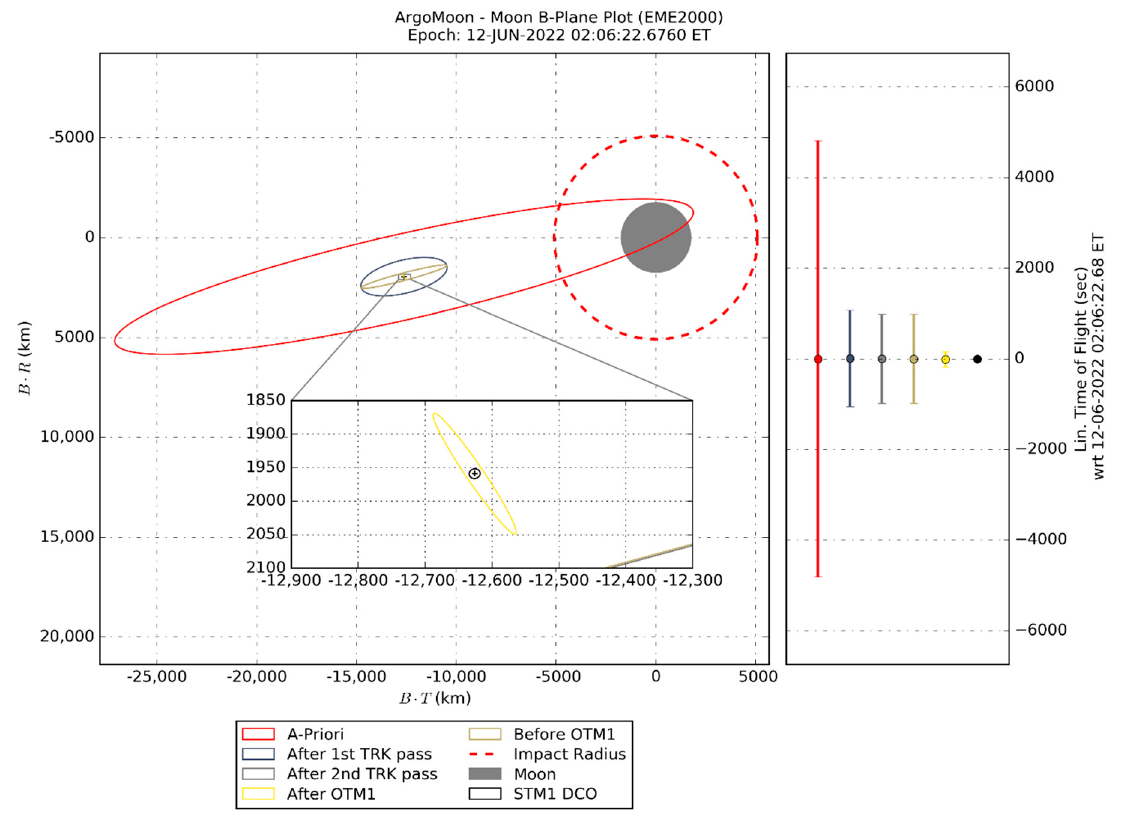
Figure 12. B-Plane uncertainties (3-sigma) for the fly-by M0 with DCO at the end of each tracking (TRK) pass up to the DCO of the STM1 (last maneuver before the fly-by). “ A-priori ” refers to the results obtained propagating the ICPS dispersion at the deployment, without processing any data.